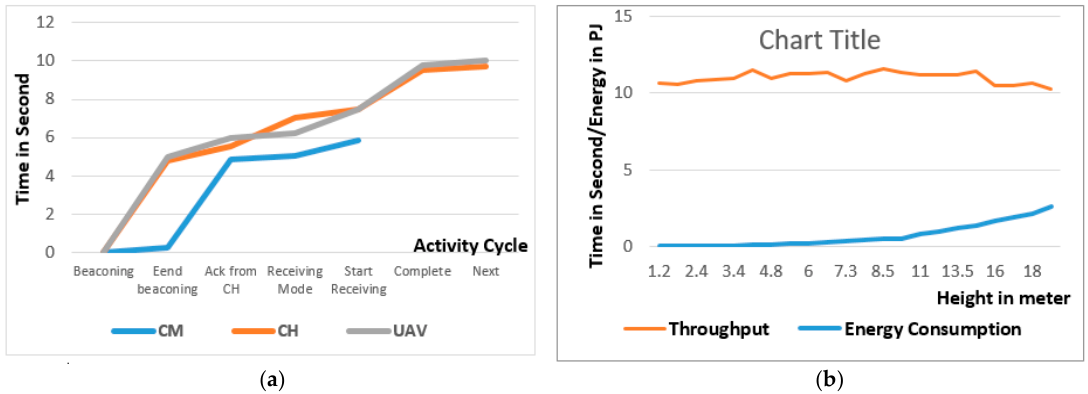
Figure 16. Performance analysis of proof of concept devices ( a ) activities of different components with respect of time ( b ) effect of varying height on throughput and energy consumption.